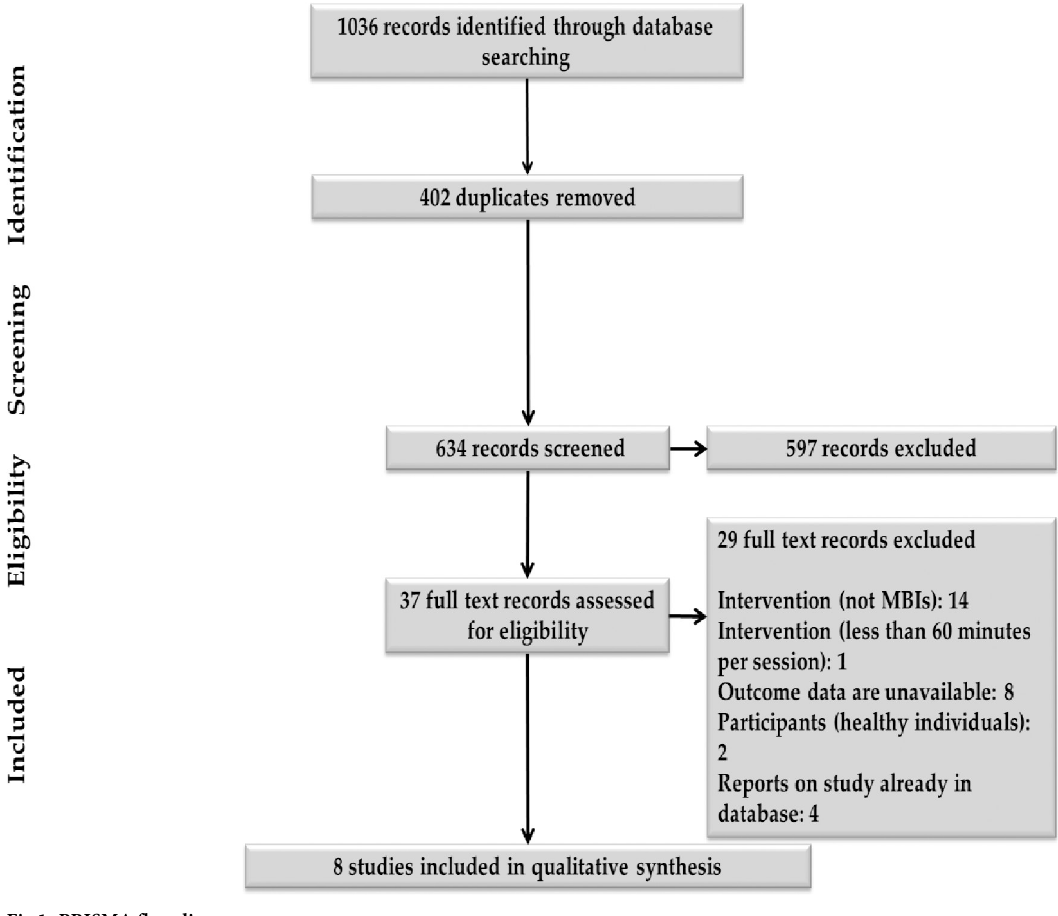
Fig 1. PRISMA flow